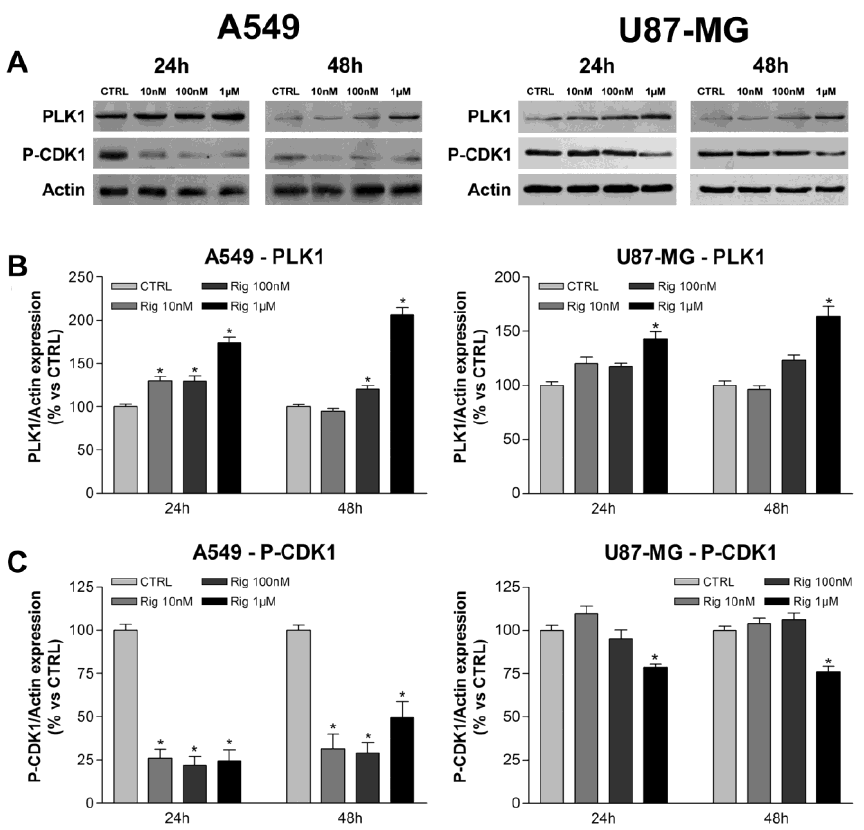
Figure 7. PLK1 and P-CDK1 protein expression in A549 and U87-MG cells. ( A ) Representative images of PLK1 and P-CDK1 western blots of A549 and U87-MG cells. ( B ) PLK1 and ( C ) P-CDK1 protein expression in A549 and U87-MG cells treated with increasing concentrations of RIG (10 nM, 100 nM, and 1 µ M) for 24 and 48 h. Graphs represent the mean ± SD of protein expression normalized to actin and to untreated controls, set at 100%. (* p < 0.05 vs. CTRL).